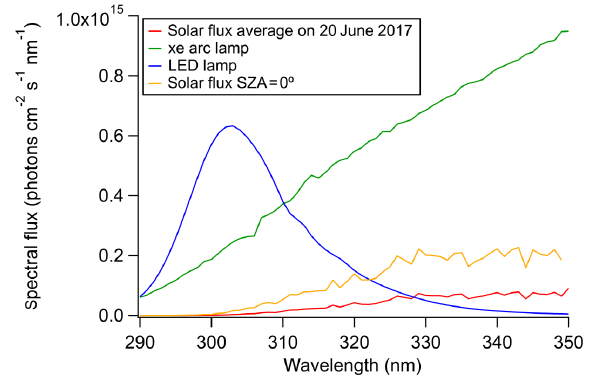
Figure 1. Spectral flux density (photonscm − 2 s − 1 nm − 1 ) approxi- mated for a solar zenith angle of 0 ◦ (orange), as well as the 24h av- erage for the latitude and longitude of Los Angeles (34 ◦ N, 118 ◦ W) on 20 June 2017 (red). The spectral flux density for the 300nm LED (blue) and the filtered Xe arc lamp (green) are also